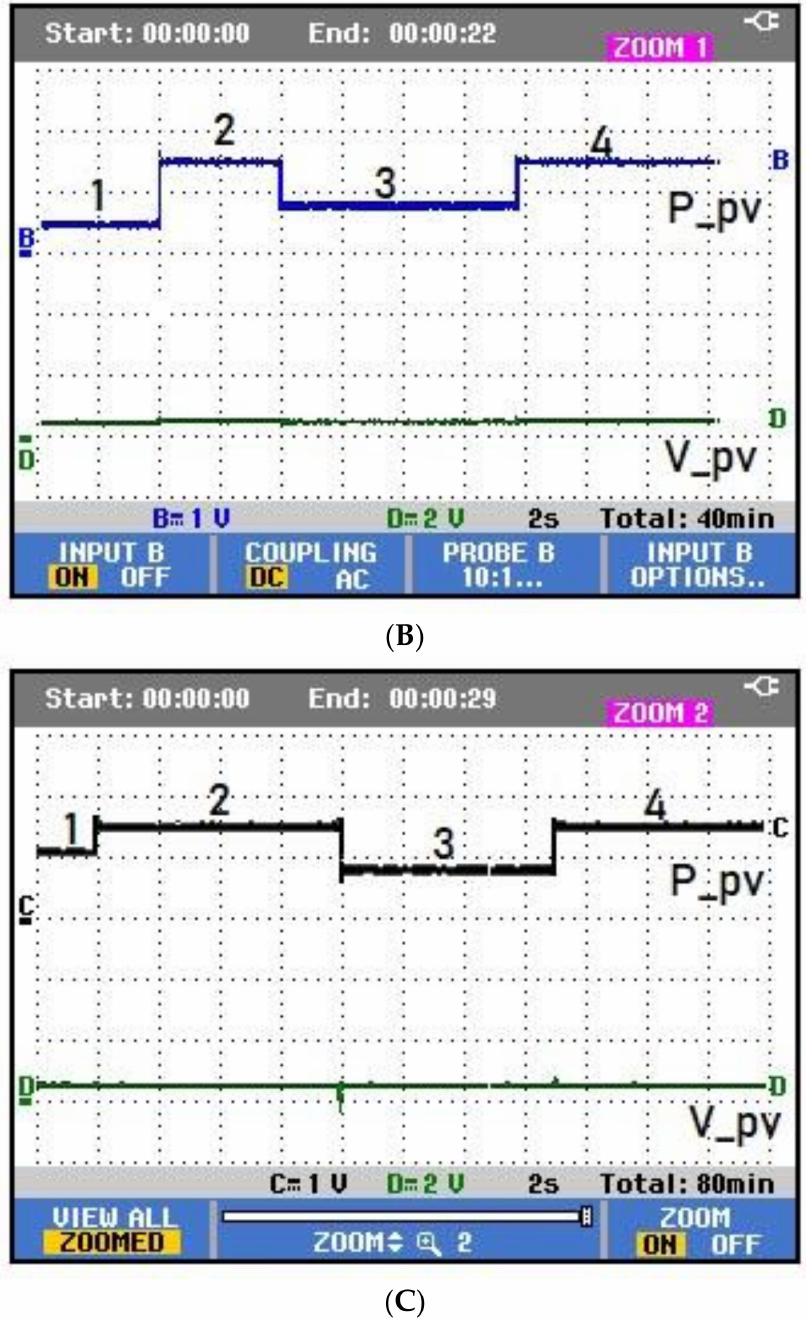
Figure 25. ( A ) Output power and voltage under varying irradiation levels and at a constant tem- perature of 25 ◦ C with MDOF-FLC. ( B ) Output power and voltage under varying irradiation levels and at a constant temperature of 25 ◦ C with SUIPID. ( C ) Output power and voltage under varying irradiation levels and constant temperature of 25 ◦ C with